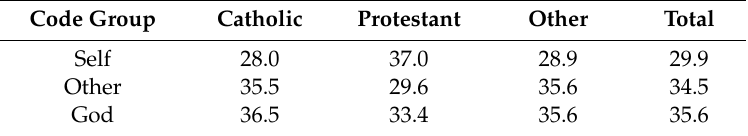
Table 12. Dimensions of everyday practices and personal context—church a ffi liation.